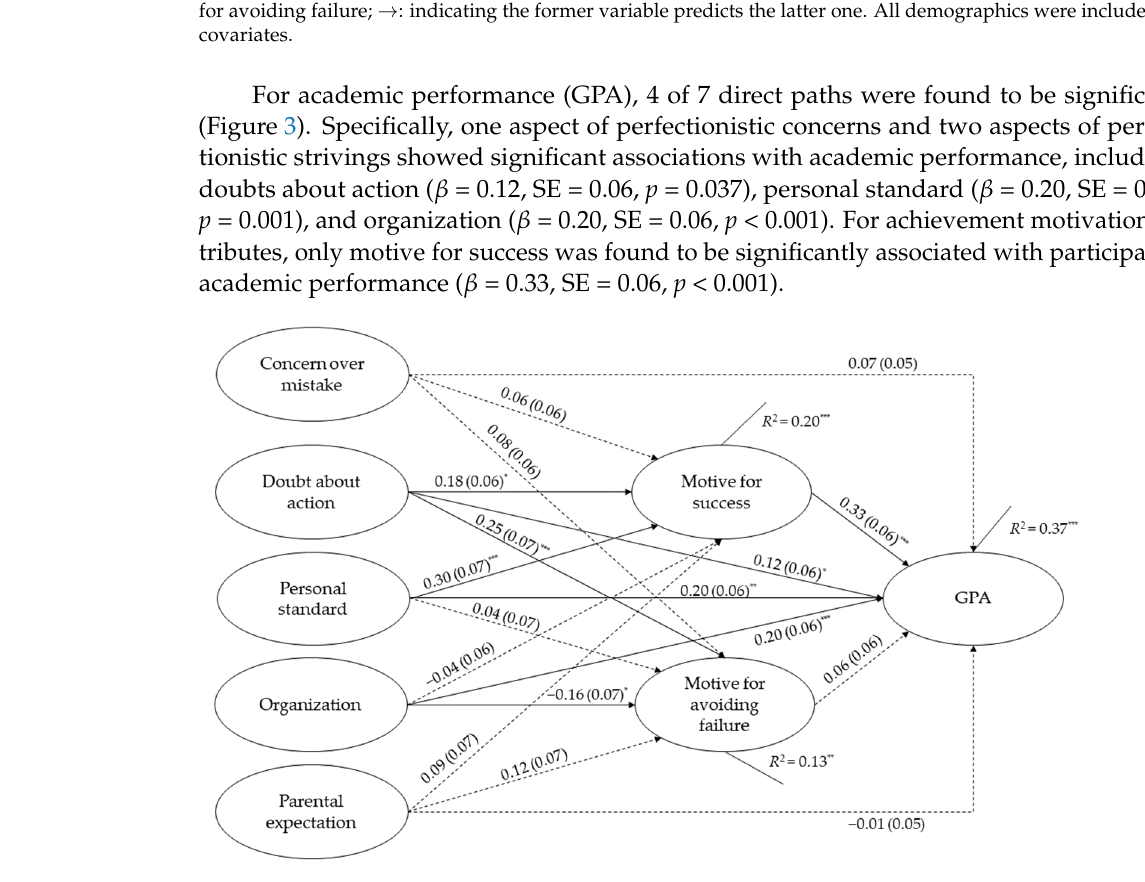
Figure 3. Final structural model with standardized path coefficients and standard errors for perfec- tionism, achievement motivation, and academic performance (GPA) ( n = 243). All the demographics were included as covariates. Significant path is indicated by solid line and non-significant path is indicated by dotted line. * p < 0.05, ** p < 0.01, *** p < 0.001.